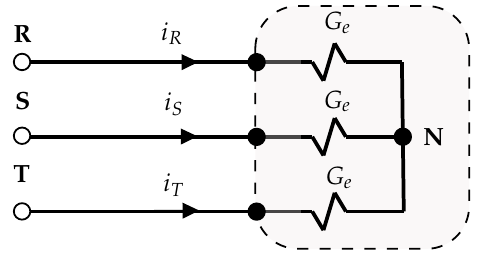
Figure 5. Equivalent three-phase balanced